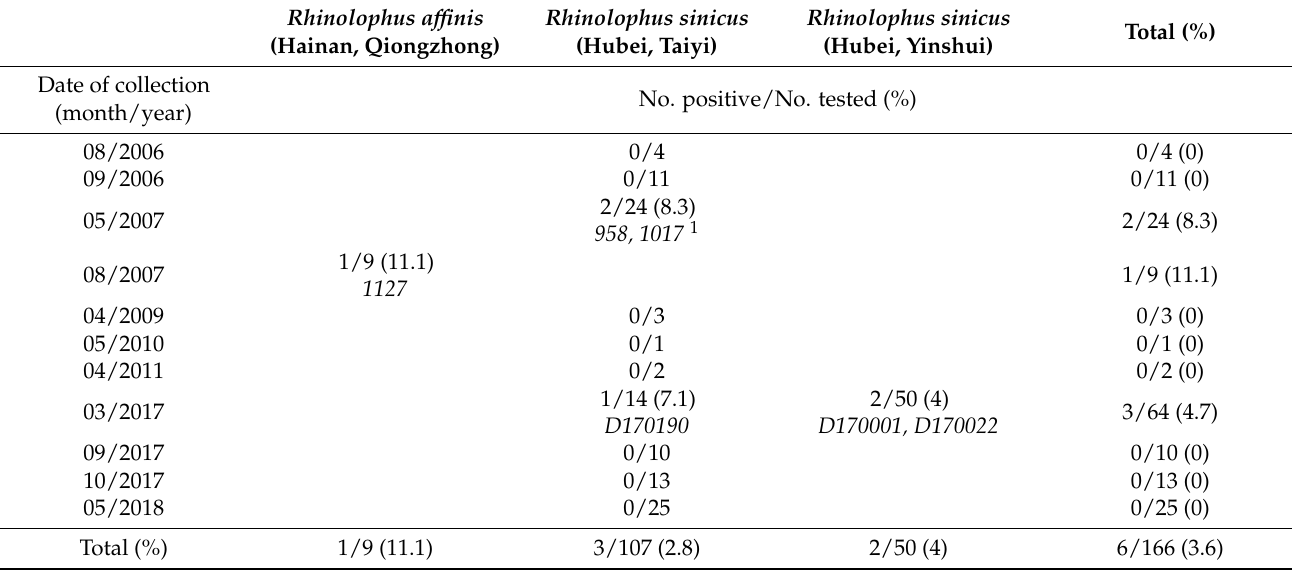
Table 2. Detection rate of rhabdovirus in brain samples of Rhinolophus sinicus and Rhinolophus affinis originating from Hubei and Hainan provinces.